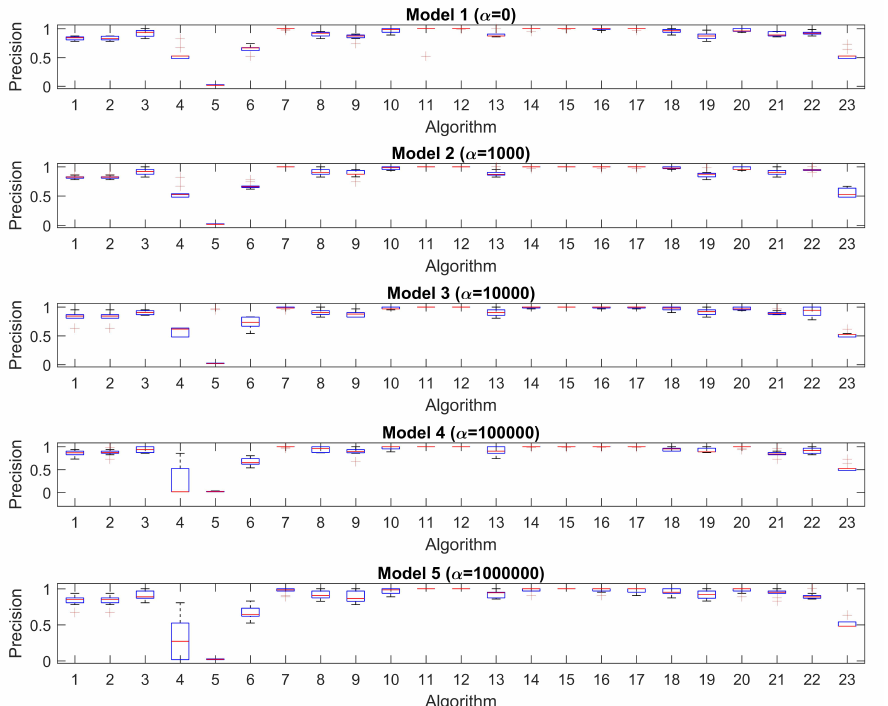
Figure A1. Numerical simulation Assumption 1. Precision of models after increasing the translation constant α for all the 23 algorithms. The 23 algorithms are represented in the x -axis, and the accuracy is shown in the y -axis.